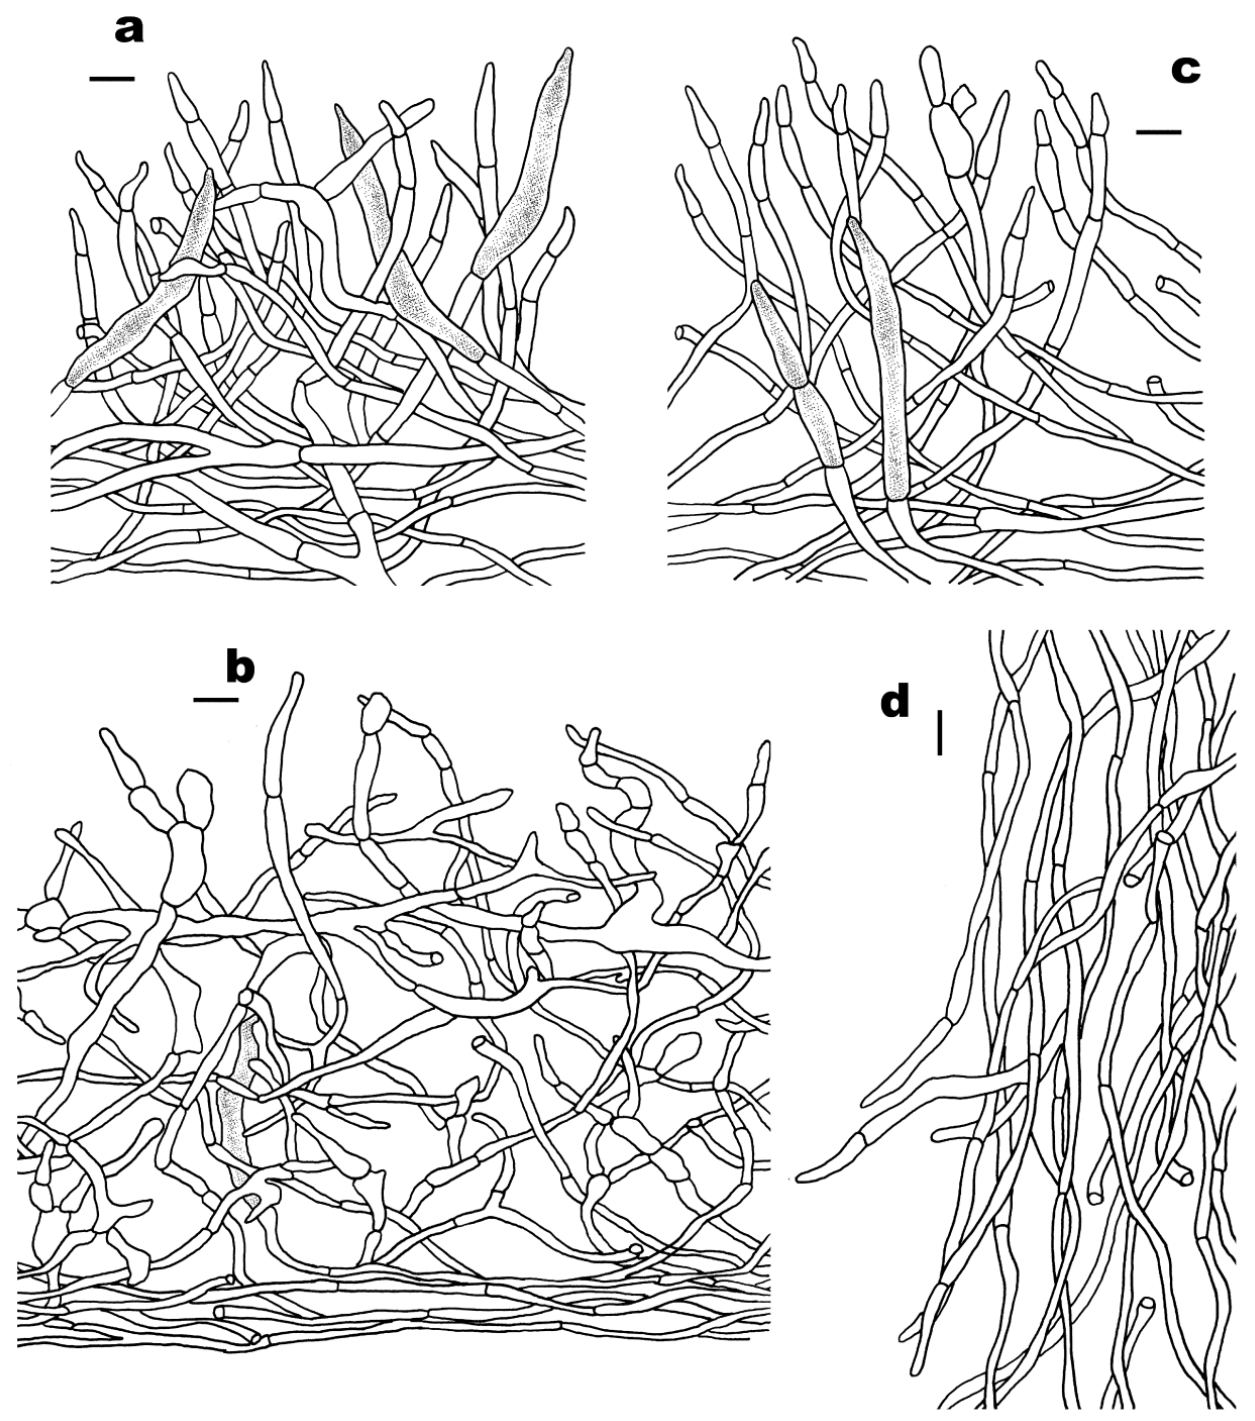
Figure 5. Microscopic features of Russula fujianensis (FHMU975, holotype). ( a ) Pileipellis at pileus margin. ( b ) Pileipellis at middle part between center and margin of pileus. ( c ) Pileipellis at pileus centre. ( d ) Stipitipellis. Bars: 10 μm. Drawings by Y.X. Han. Russula oraria N.K. Zeng, Y.X. Han and Zhi Q. Liang, sp. nov. (Figures 2c,d, 3c,d, 6 and 7).